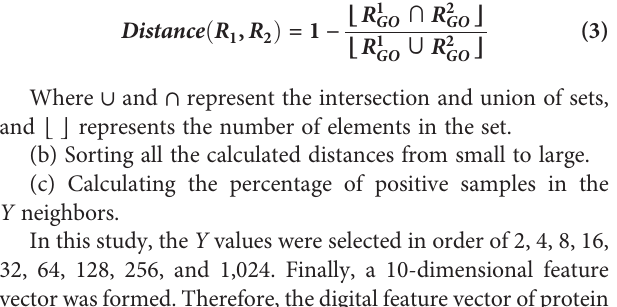
TABLE 1 | Data set for prediction of pupylation protein and pupylation site. Datasets